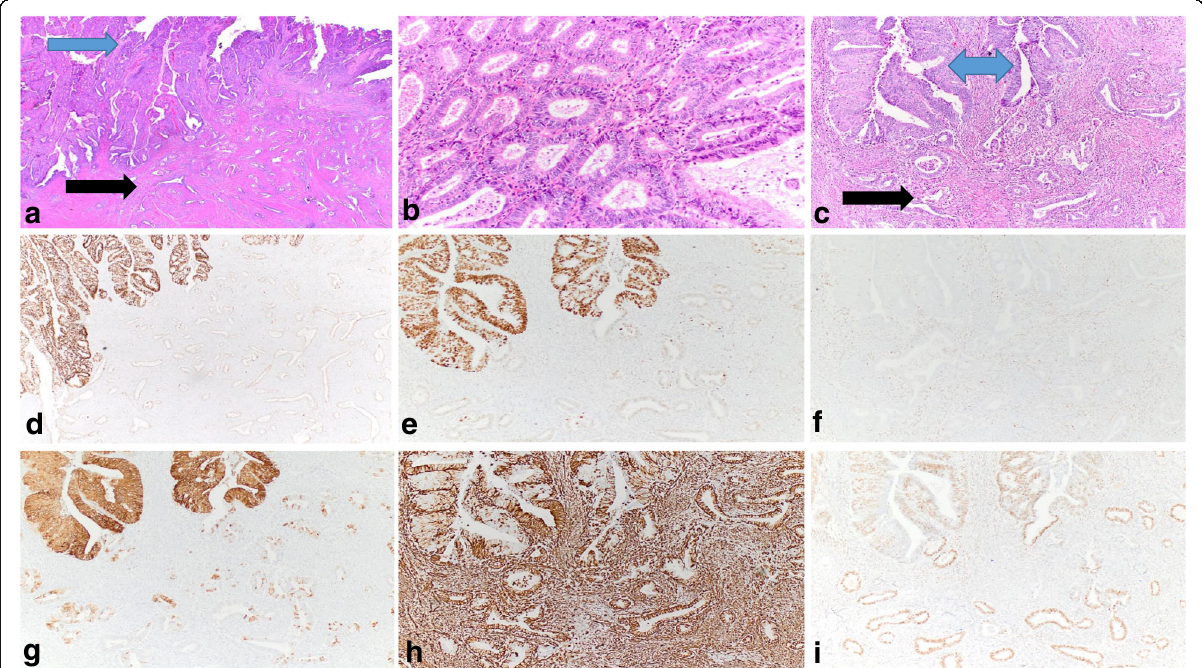
Fig. 1 Morphologic and immunophenotypic features of tumor in the uterus: a Focus of myometrial invasion (black arrow) with overlying endometrial tumor (blue arrow) (H and E, original magnification: 2 x). b The p53-wild type areas of the tumor (H and E, original magnification: 40X). c Transitional areas between myoinvasive glands (black arrow) and overlying, non-myoinvasive parts of tumor (blue arrow) (H and E, original magnification: 40X). d and e p53 immunohistochemistry showing wild-type staining pattern in the myoinvasive glands and aberrant staining pattern in the overlying, non- myoinvasive parts of tumor (original magnifications: 1D: 2X; 1E: 10X). f Loss of MSH2 in both components of the tumor (original magnification: 10×). g p16 immunohistochemistry showing mosaic staining pattern in the myoinvasive glands and diffuse staining pattern in the overlying, non-myoinvasive parts of tumor (original magnification: 10X). h Vimentin expression in both components of the tumor (original magnification: 10×). i Estrogen receptor expression in both components of the tumor (original magnification: